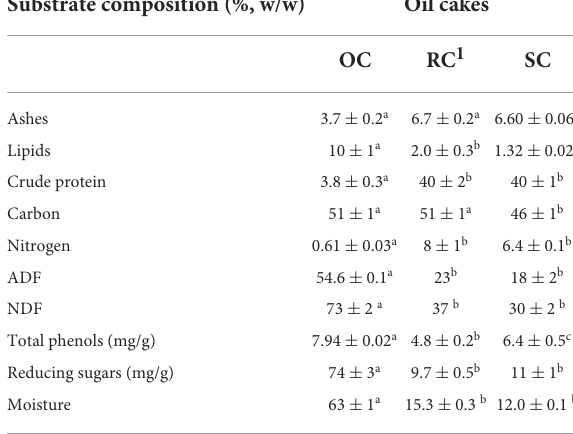
TABLE 1 Characterization of OC, RC, and